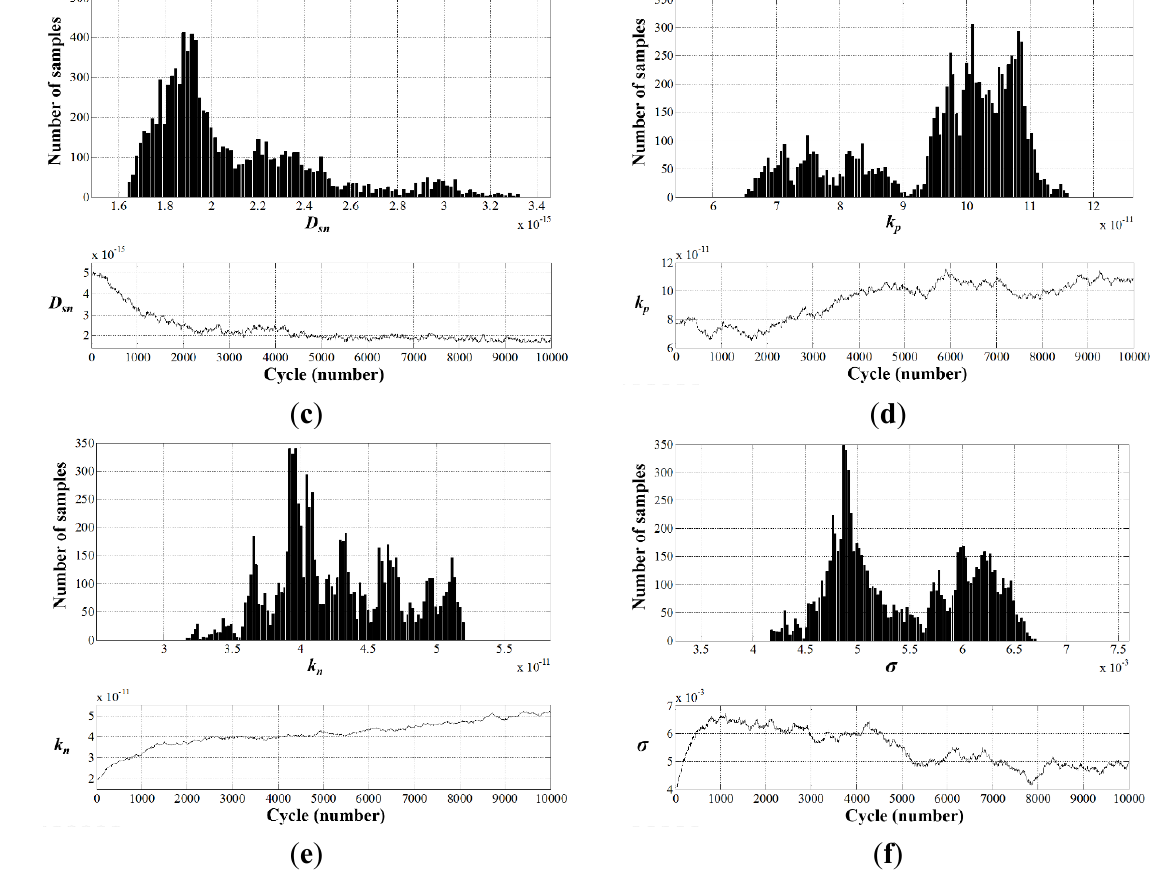
Figure 4. Parameter estimation as a result of voltage data at cycle 1200 (capacity fade 17.7%). The upper histograms show the number of samples of the M-H algorithm over the probable range, which represents the estimated PDF. The lower plots show the values of each parameter up to 10,000 iterations, as explained in Figure 2: ( a ) liquid-phase diffusivity D e ; ( b ) solid-phase diffusivity in the positive electrode D sp ( c ) solid-phase diffusivity in the negative electrode D sn ; ( d ) electrochemical reaction-rate constant in the positive electrode k p ; ( e ) reaction-rate constant in the negative electrode k n ; ( f ) standard deviation σ of the likelihood